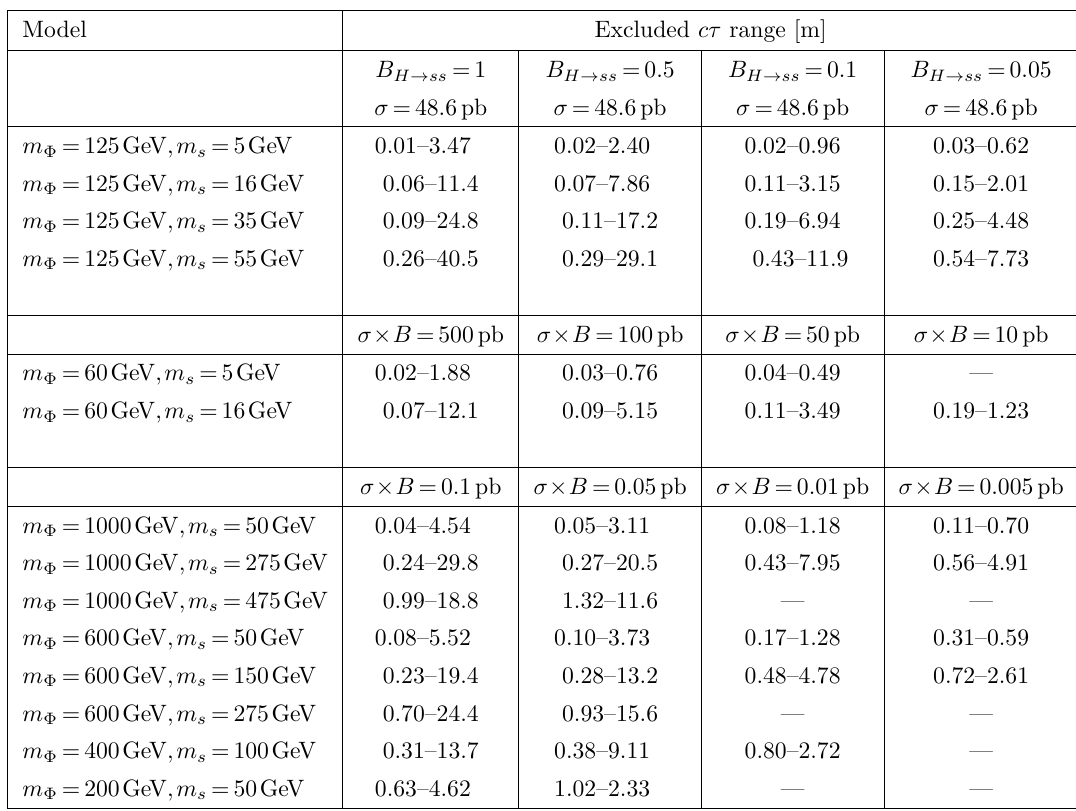
Table 5. Summary of the cτ values which are excluded at 95% CL for the models considered in this